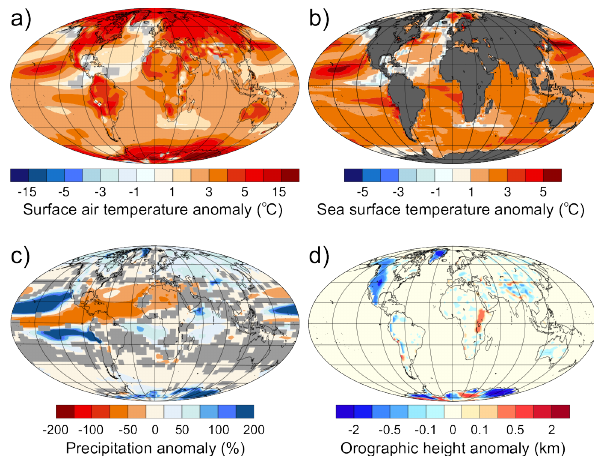
Fig. 4. Annual mean difference between the Messinian control versus the modern (pre-industrial) control simulation (as used by Ivanovic et al., 2014) for (a) surface air temperature (in ◦ C), (b) sea surface temperature (in ◦ C), (c) precipitation (%), and (d) surface orography (in km). Anomalies with < 95% confidence in signifi- cance using a student t test are masked in light grey. For orienta- tion, a modern coastal outline is shown, latitude parallels are 20 ◦ apart and longitude parallels are 30 ◦ apart. Figure 10 also uses this